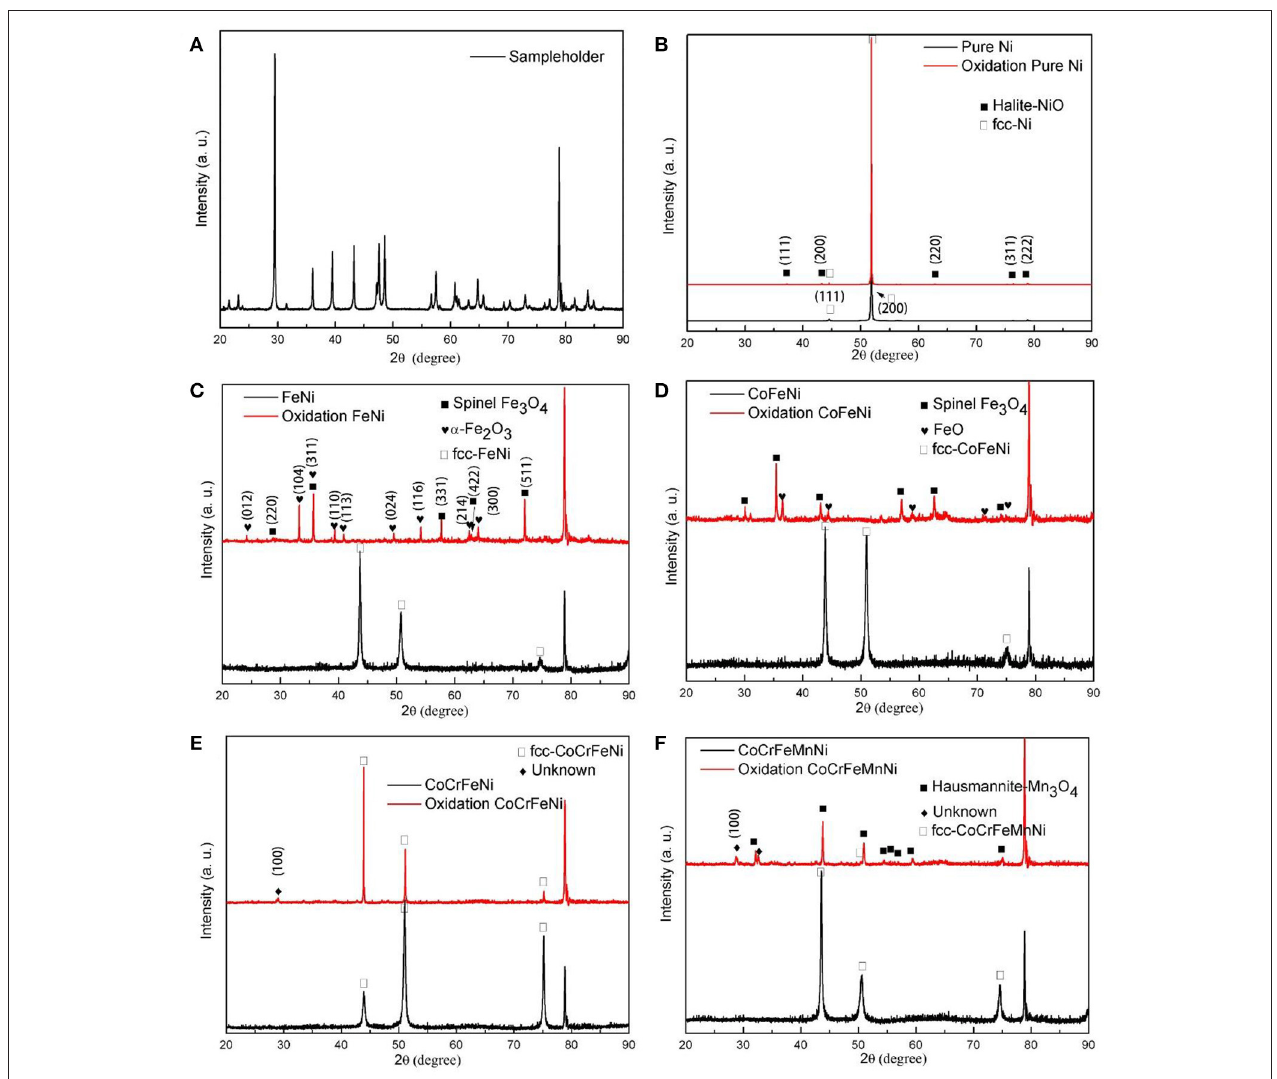
FIGURE 8 | XRD patterns on the pure Ni and other studied alloys at 800 ◦ C for 150min. (A) Sample holder; (B) Pure Ni; (C) FeNi; (D) CoFeNi; (E) CoCrFeNi; (F)